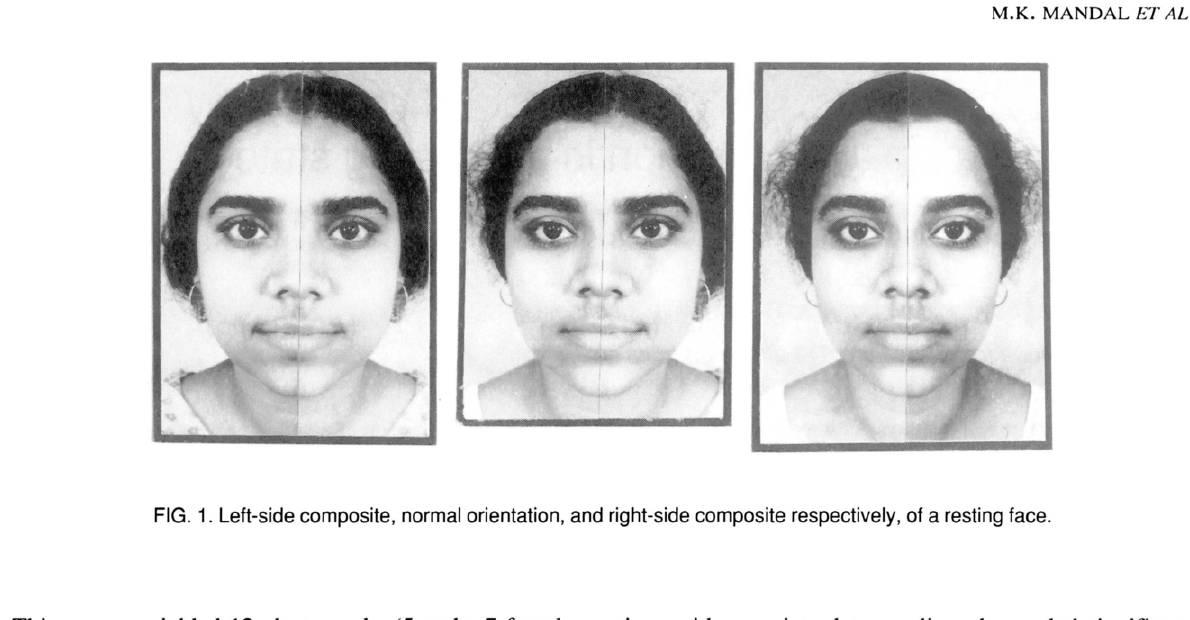
This process yielded 12 photographs (5 male, 7 female, mean age = 24.0 and S.D. 2.27 years) of neutral facial